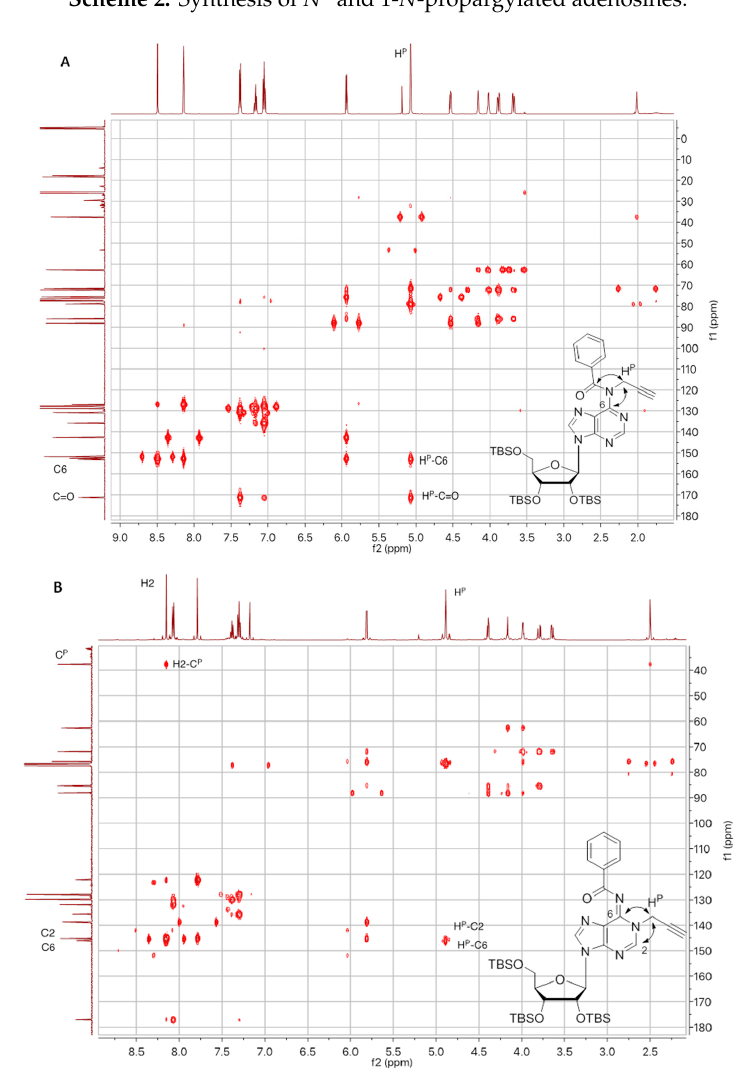
Figure 2. 2D HMBC spectra (500 MHz, CDCl 3 ): ( A ) N 6 -propargyladenosine derivative 2a . ( B ) 1-propargyladenosine derivative 3a .